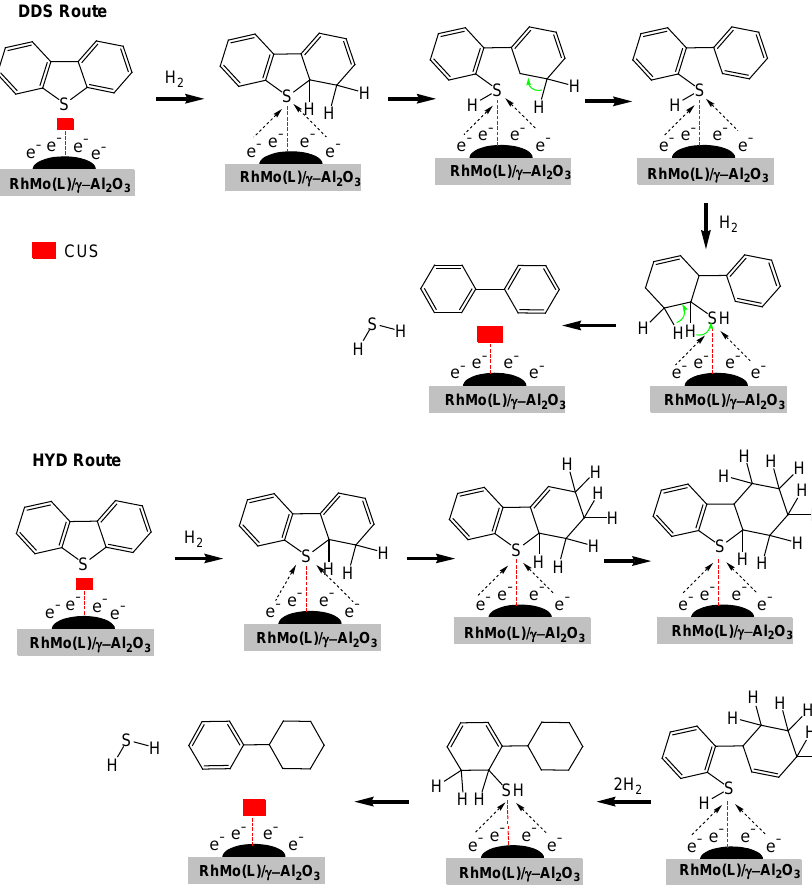
Scheme 1. Proposed mechanisms of DDS and HDS reaction on RhMo chelated catalysts in HDS of